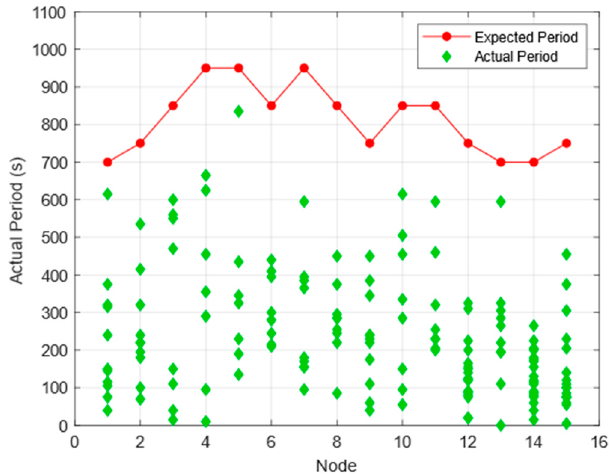
Figure 11. The monitoring period in an incomplete environment obtained by OMACO algorithm.